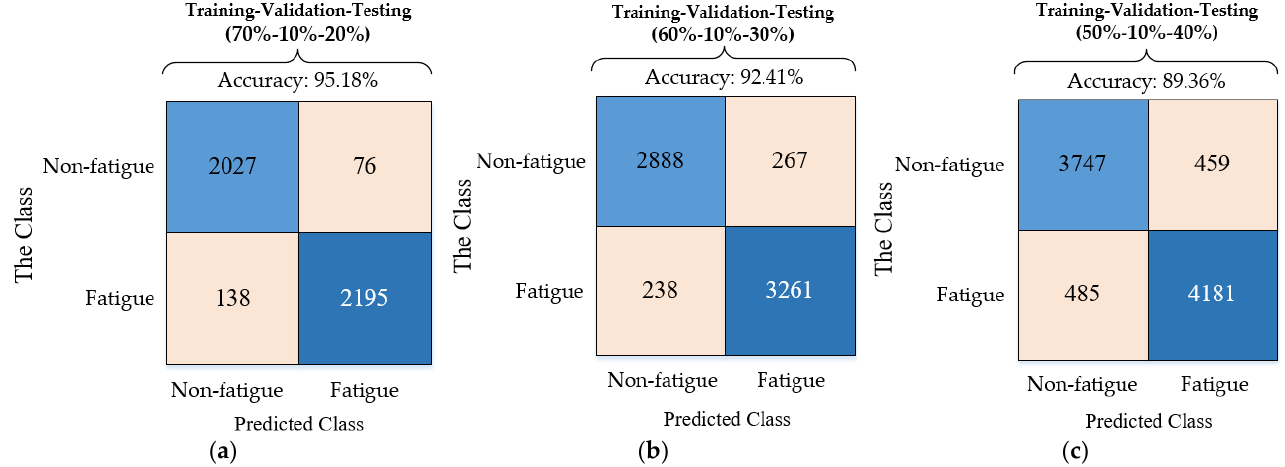
Figure 10. Confusion matrix results for sEMG feature data and the rates of training – validation – testing.